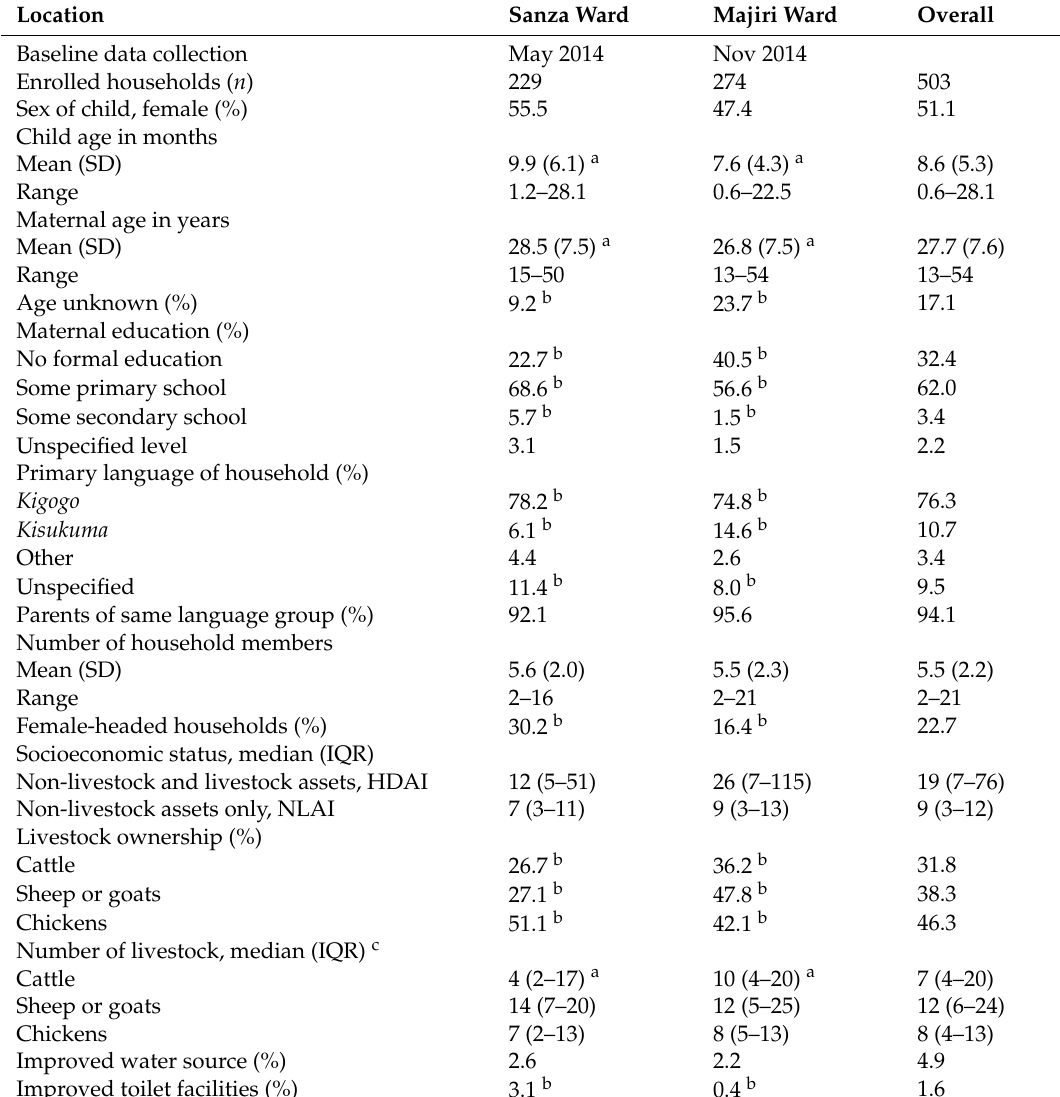
Table 2. Overview of study population according to baseline questionnaire responses, by ward and